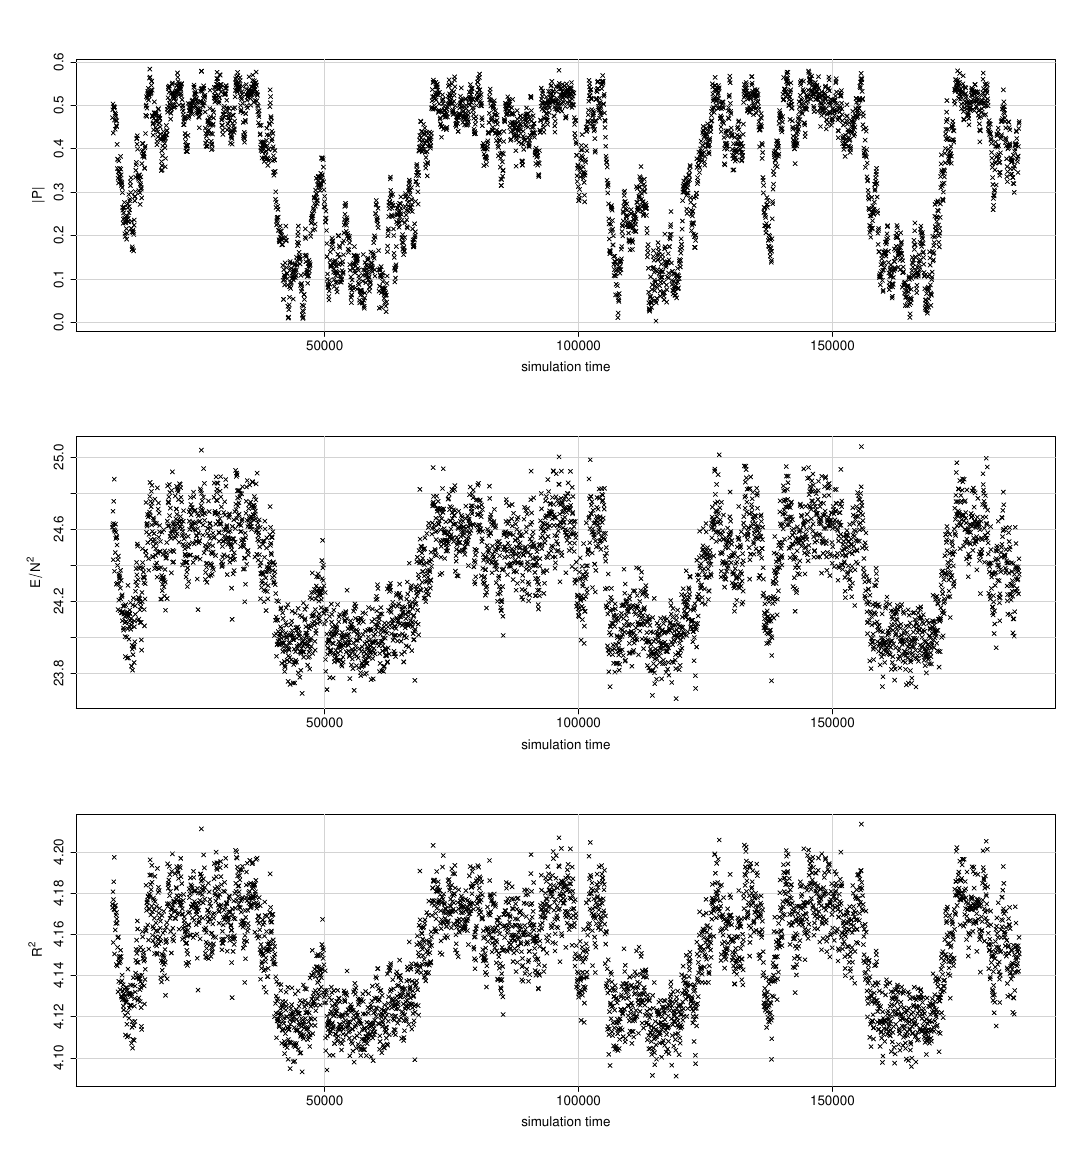
Figure 23. Simulation history for N = 64, L = 24, D = 26, T = 0 : 8732. Only every 50th mea- surement is shown. Con(cid:12)gurations are dropped at the beginning to remove thermalization e(cid:11)ects.